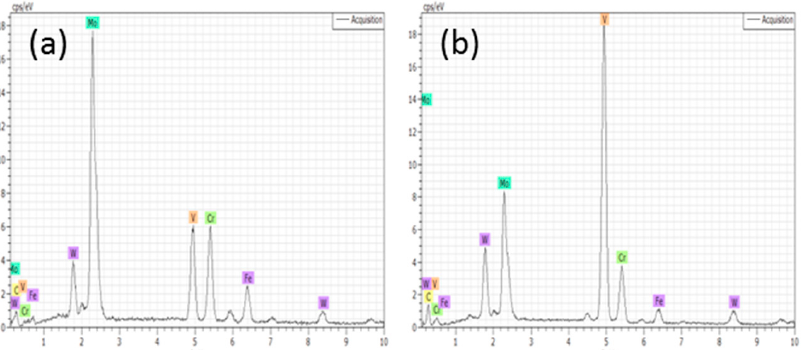
Figure 5. EDS analyzed results of M 2 C ( a ) and MC ( b ) carbides.